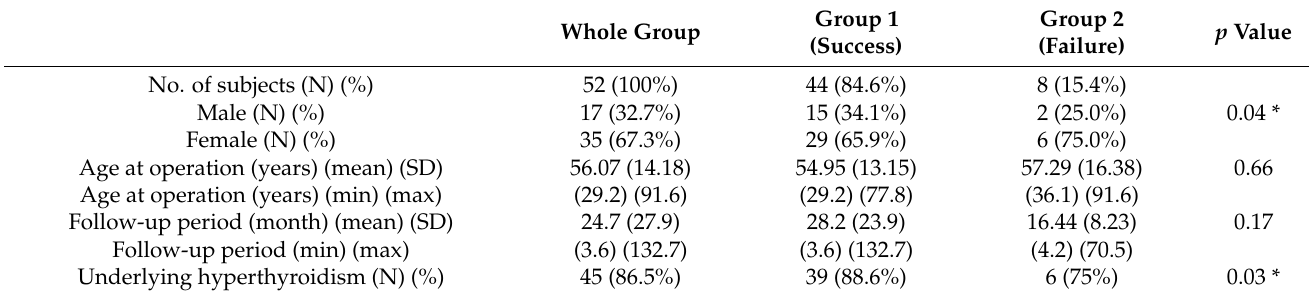
Table 1. Demographic characteristics of the patients in the